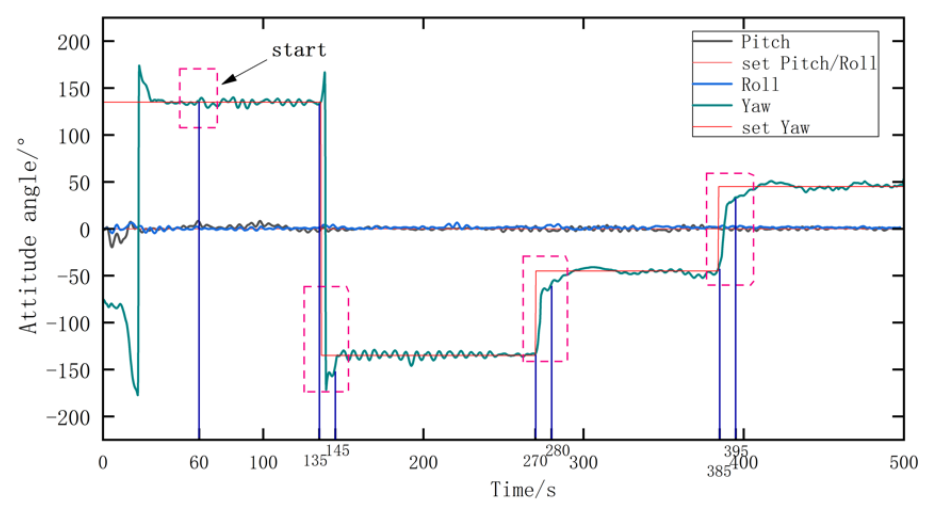
Figure 22. Attitude control results in navigation mode.